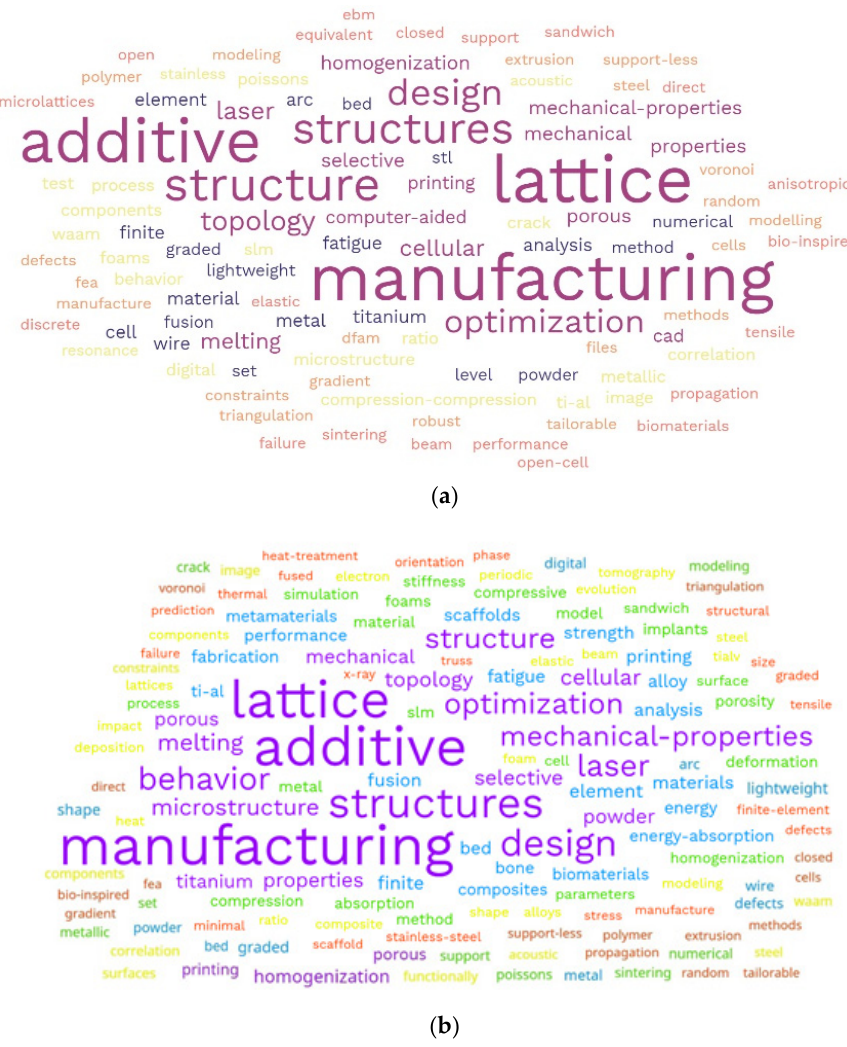
Figure 12. Word cloud on keywords published articles on “additive manufacturing on lattice struc- ture” research (data retrieved from WoS database on 20 June 2022), showing ( a ) scheme 1 and ( b ) scheme 2.